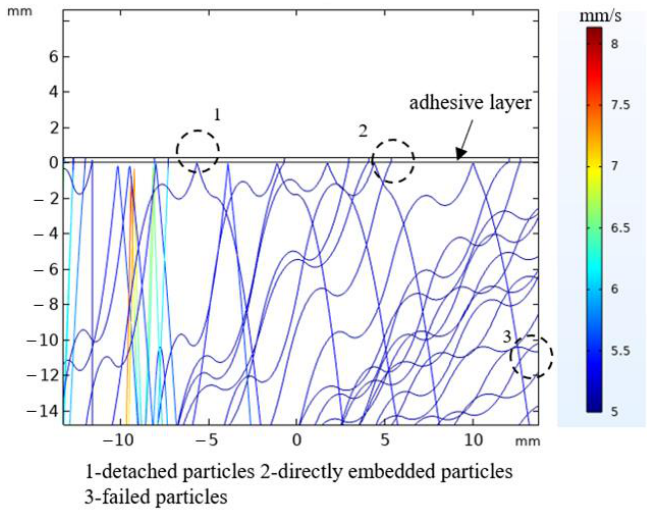
Machines 2022 , 10 , x FOR PEER REVIEW 11 of 17 Figure 10. Abrasive particle paths in the mechanical model. Figure 10. Abrasive particle paths in the mechanical model. Figure 10. Abrasive particle paths in the mechanical model.